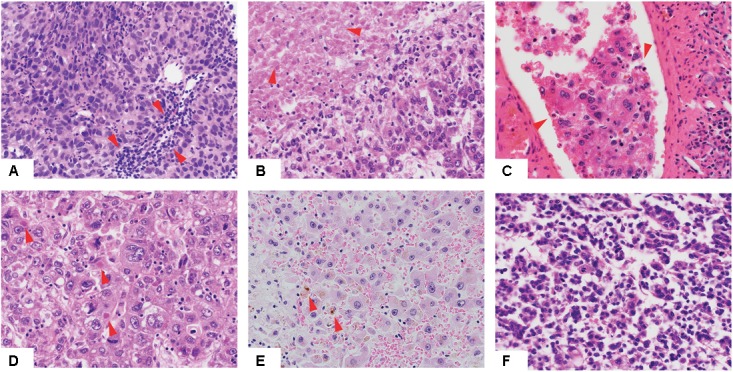
Histologic features of hepatocellular carcinoma. Low-power view of hepatocellular carcinomas with tumor infiltrating lymphocytes (A), necrotic areas (B), vessel infiltration (C), Mallory bodies (D), cholestasis (E) and of high Edmondson grade (F). Red arrows indicate the relevant histologic features.